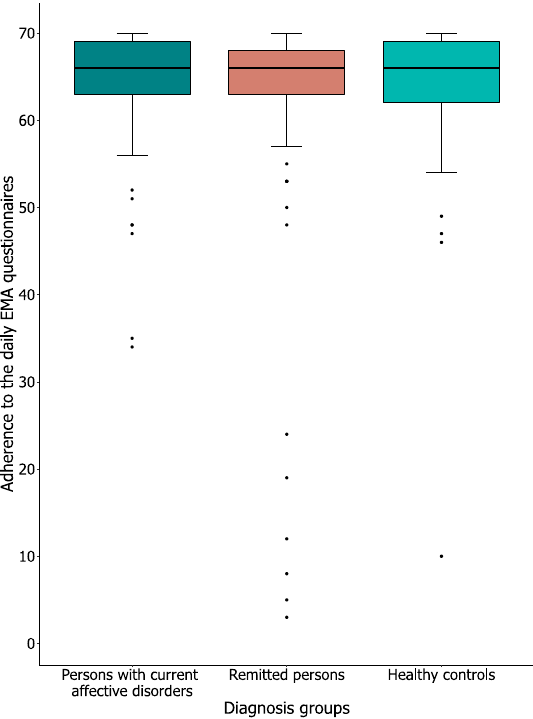
Figure 4. Adherence to the EMA questionnaires. Note: Participants were invited to conduct a total of 70 EMA questionnaires. Thick black line shows the median, error bars show the interquartile range (IQR), whiskers show +/-1.5 IQR, and • = outlier, deviates by ≥ 1.5x IQR.